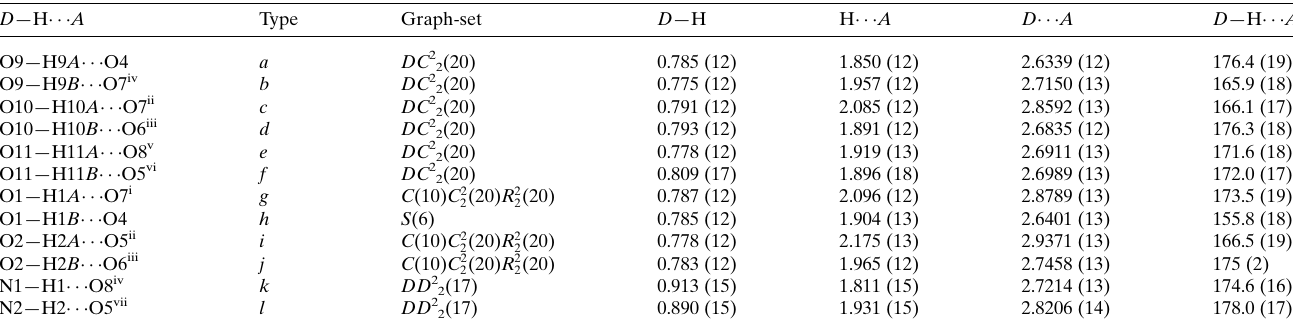
Table 1 Hydrogen-bond geometry (A˚ , (cid:3) ).